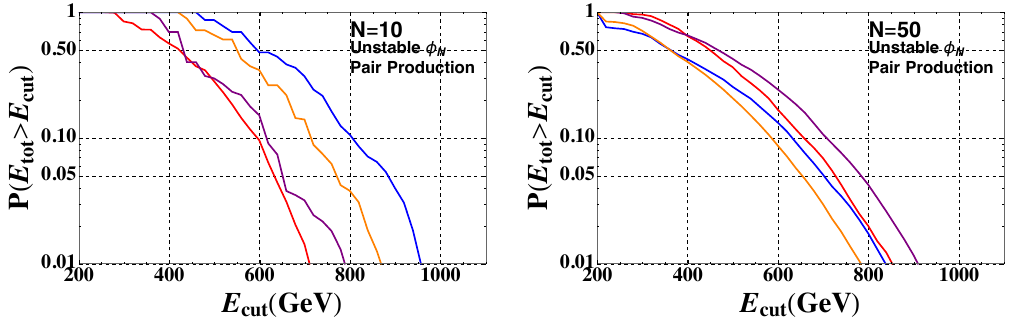
Figure 17. Fraction of events with total energy (including missing energy) above E were made in the scenario where all couplings in eqs. (3.1) and (3.2) are present and pair production dominates. Left: 10 scalars, right: 50